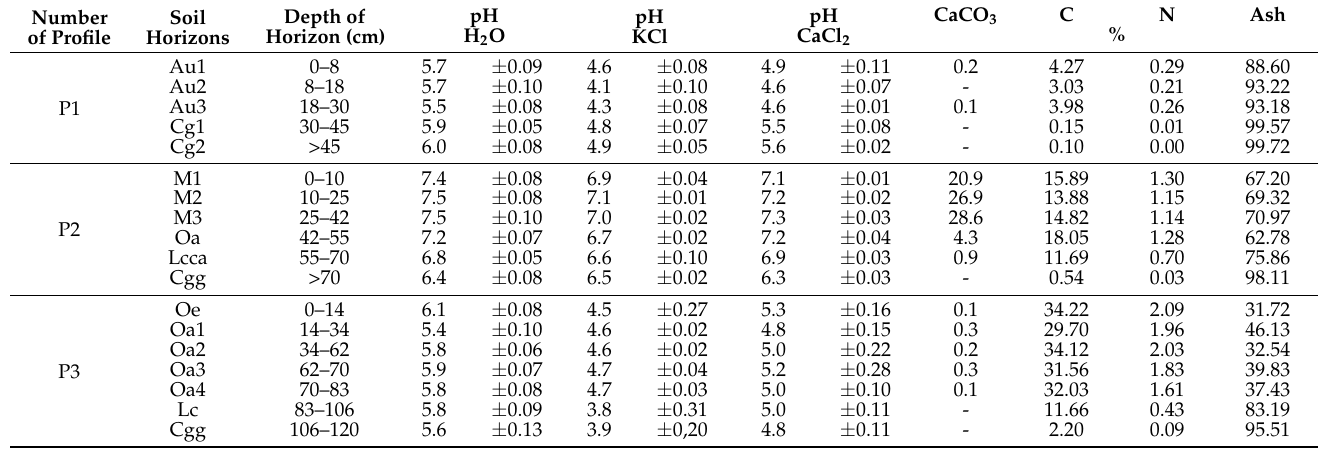
Table 2. Physicochemical and chemical properties of soil and ash